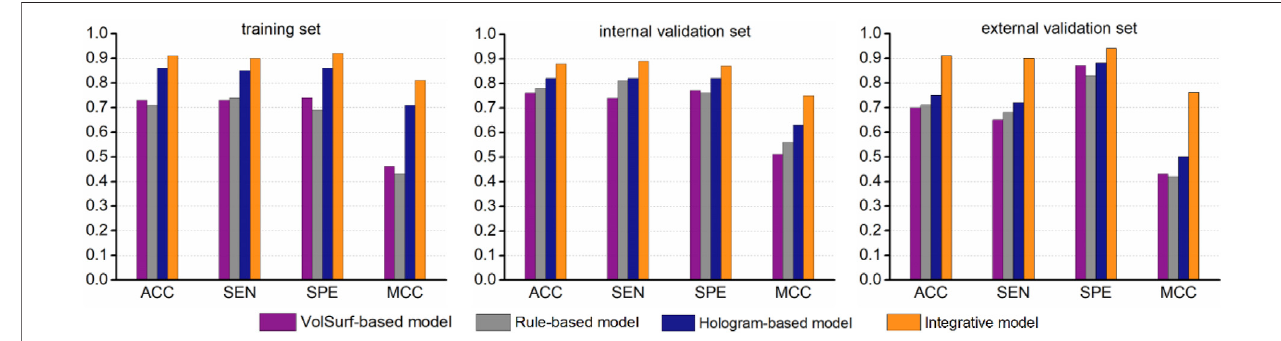
FIGURE 5 | Comparison of the performance of the integrative model with the single classi fi